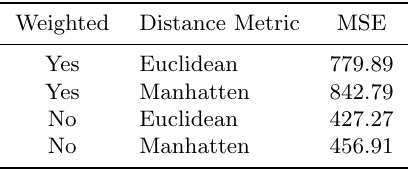
Table 5: MSE values for various KNN parameter